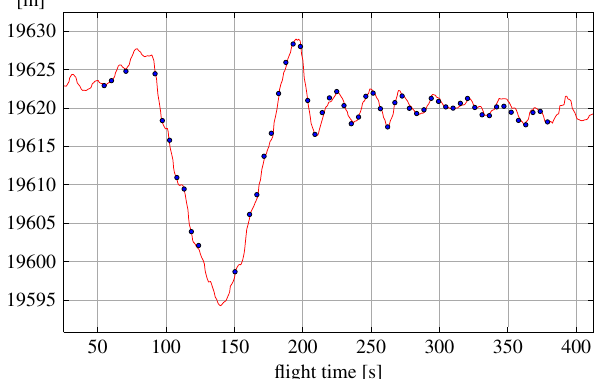
Figure 8: Comparison of direct and indirect georeferencing for the x-coordinate. The red line represents the direct georeferenc- ing result, whereas the blue dots correspond to the indirect geo- referencing.